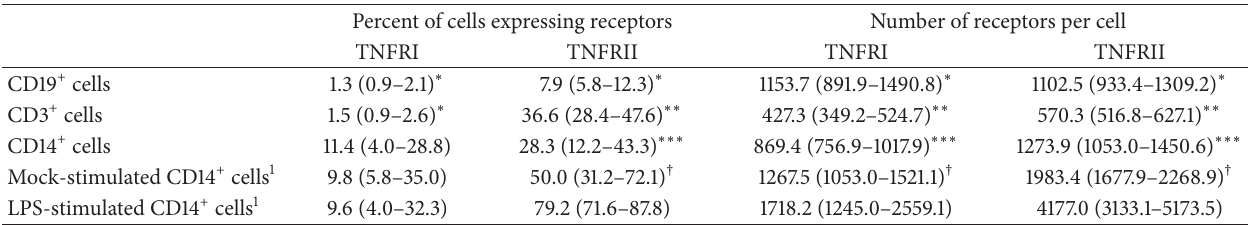
Table 2: The level of membrane-bound TNF 𝛼 types I and II receptors expressed on CD3 + , CD19 + , or CD14 + PBMC subpopulations.